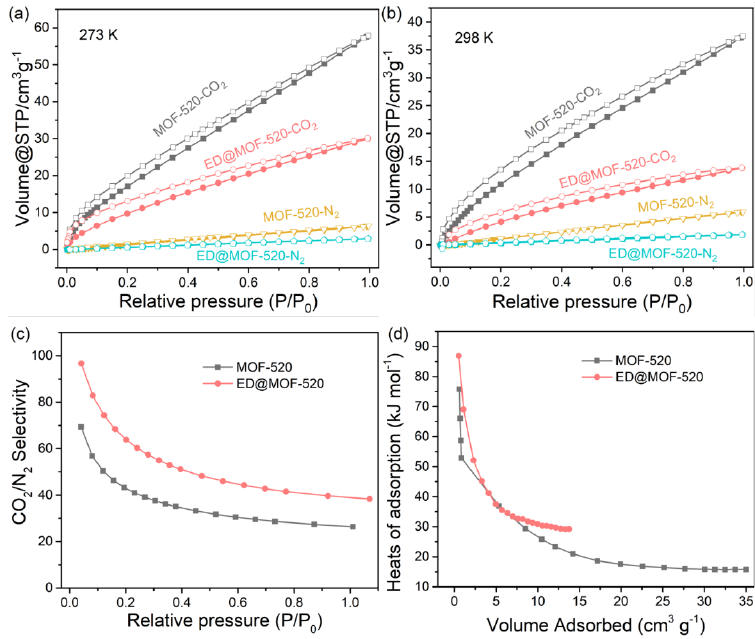
Figure 6. CO 2 and N 2 adsorption and desorption isotherms of ED@MOF-520 materials with different ED content at ( a ) 273 K and ( b ) 298 K, ( c ) CO 2 /N 2 selectivity at 273 K, ( d ) CO 2 adsorption enthalpy curves. Table 2. The comparison of BET area and CO 2 capture performance in this work and reported amine-functionalized MOFs. Samples